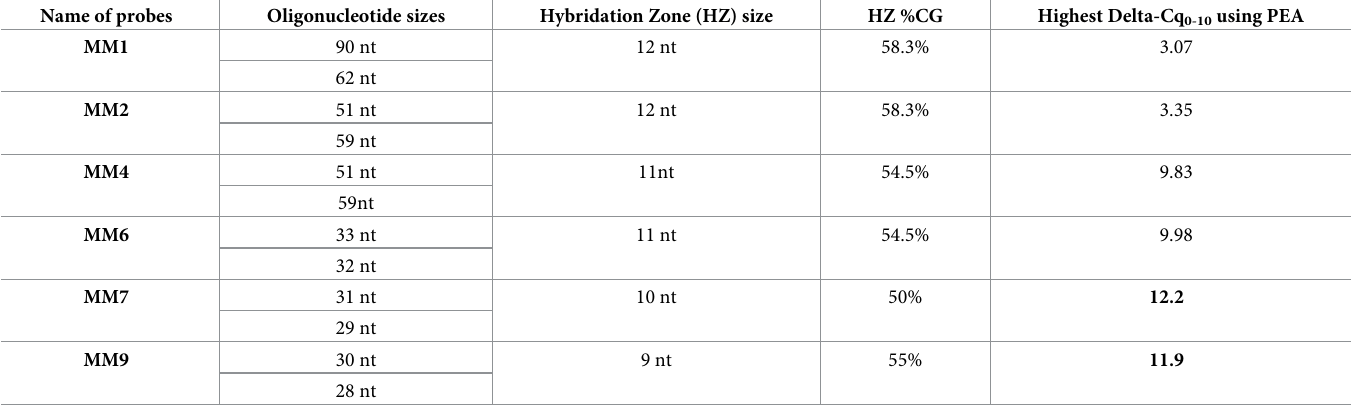
Table 1. Main characteristics of the oligonucleotide sets used for PEA. Name of